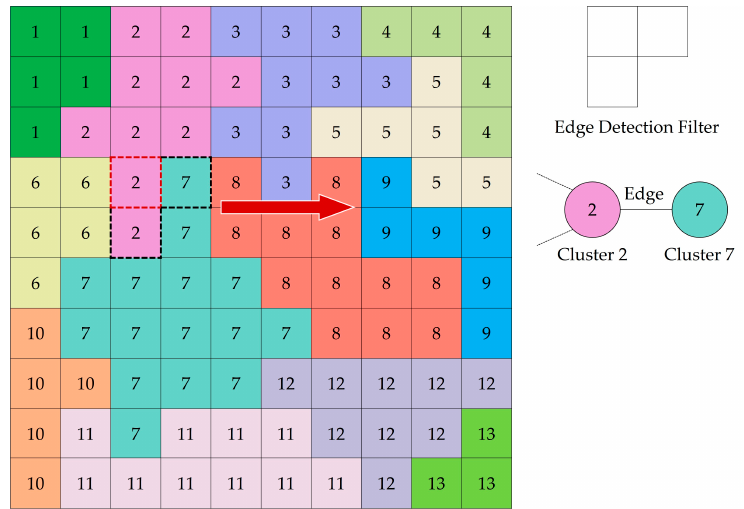
Figure 3. The neighborhood relation between Cluster 2 and Cluster 7 is detected for the first time, and the corresponding edge is created in the RAG.